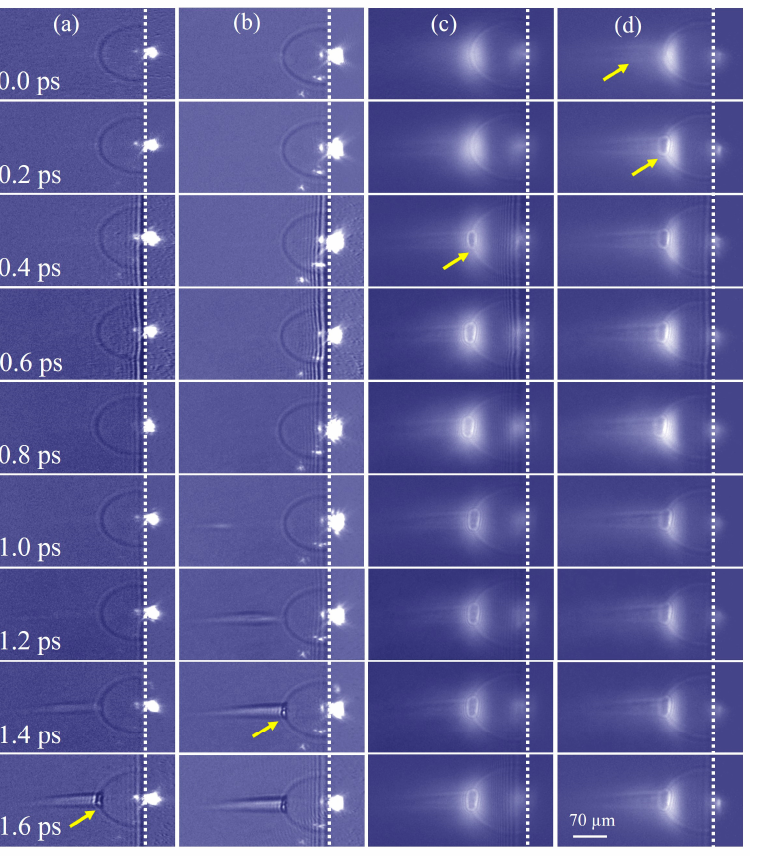
Figure 4. Time evolution of shock wave generated by a femtosecond pulse laser ablation on the surface of fused silica under ( a ) 800-o; ( b ) 800-e; ( c ) 400-o, and ( d ) 400-e probe pulse. The white dotted line is the interface between air and sample. The first yellow arrow in column ( d ) indicates the formation of an air ionization channel. The other yellow arrows indicate the area of interaction between air ionized plasma and the air shock wave.